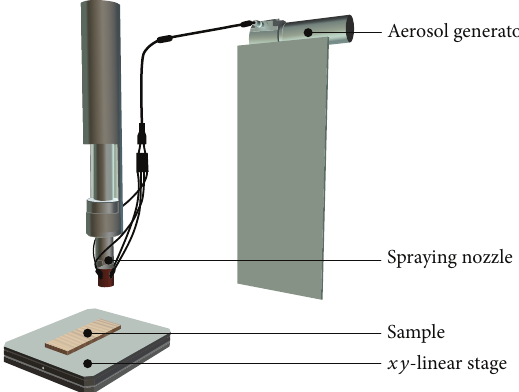
Figure 2: Setup of the used plasma coating